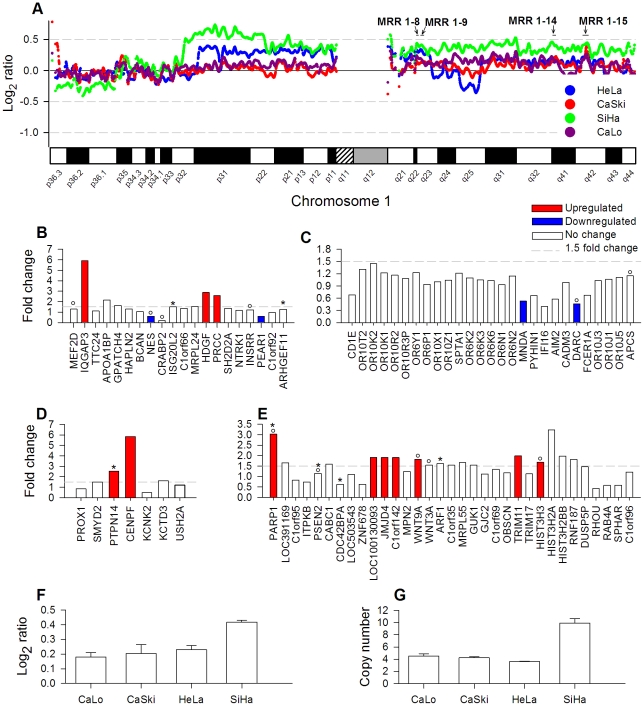
Genome amplification and deregulation of gene expression in Chr 1q.Panel A shows the copy number log2 ratio of SNPs investigated in Chr 1 by the 100 K SNP microarray in HeLa, CaSki, SiHa, and CaLo. Panels B to D show the fold change of gene expression of genes evaluated by the ST1.0 expression microarray located at MRRs 1-8, 1-9, 1-14 and 1-15. The genes are ordered according to position in the genome. For panel F, the mean ± S.D. of the log2 ratio signal of 110 SNPs located in the MRR-15 was plotted. In panel G is shown the copy number of PARP1 gene calculated by qPCR in triplicate experiments. See the legend of Figure 2 for further information.